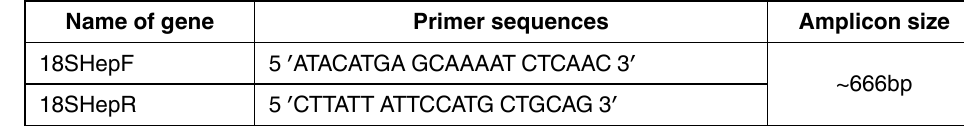
table 1. Primer sequences targeting 18S rRNA gene specific for Hepatozoon spp